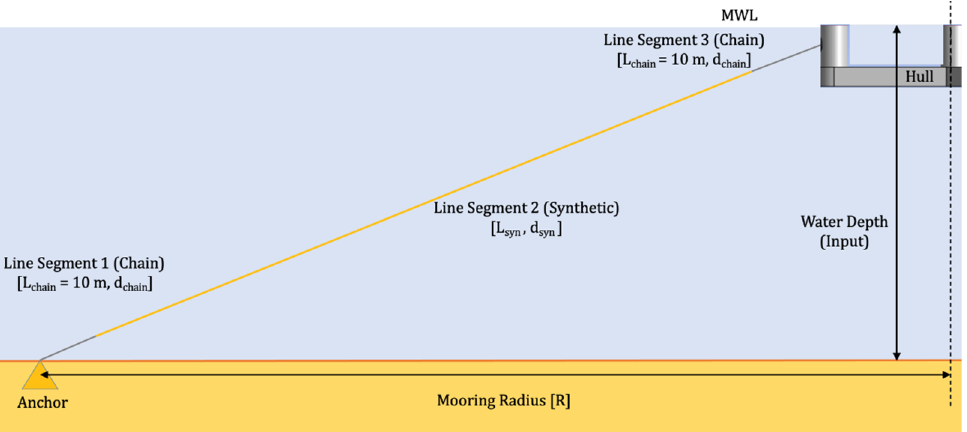
Figure 4. Mooring System Schematic for Optimization.